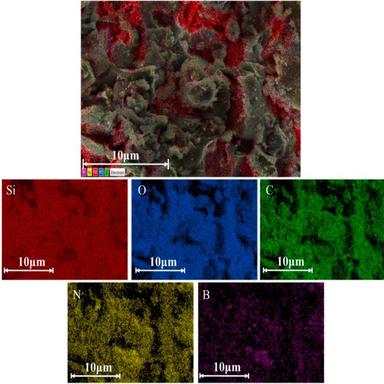
EDS images of BNNB-SiCN material. Nanoparticles are colored based on atomic composition.